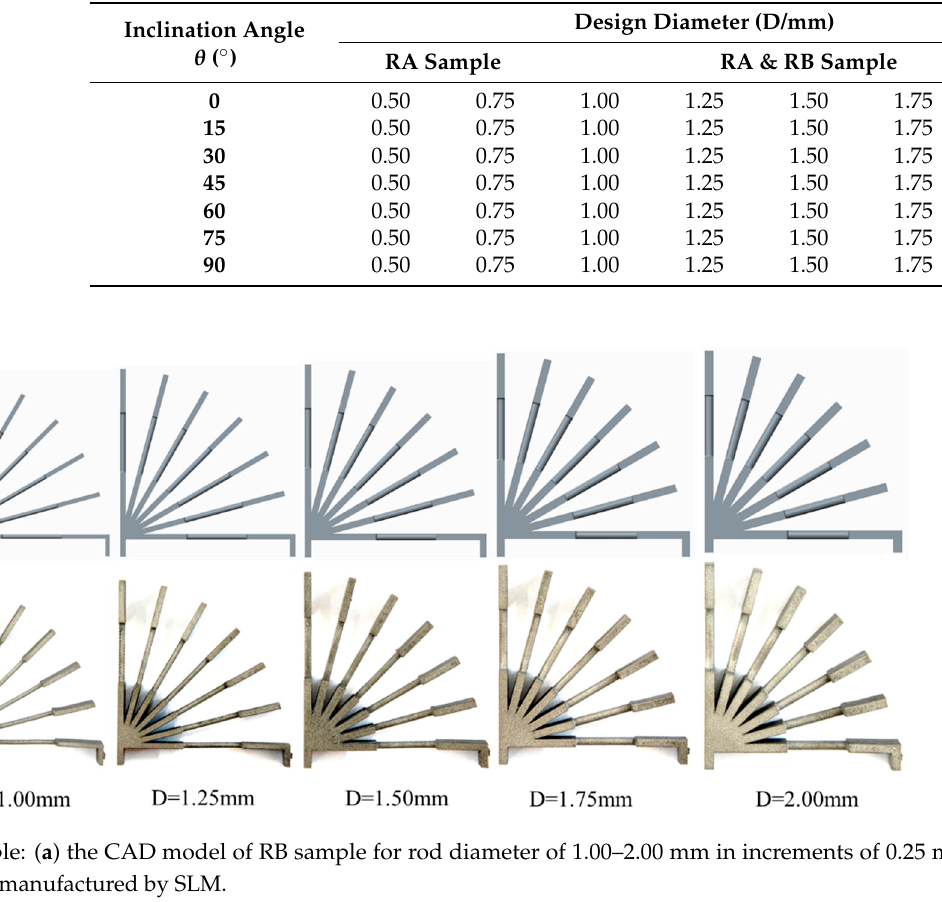
Figure 2. RA sample: ( a ) the CAD model of RA sample for rod diameter of 0.50–2.00 mm in increments of 0.25 mm and ( b ) RA Sample manufactured by SLM. Table 1. The design parameter of the sample.